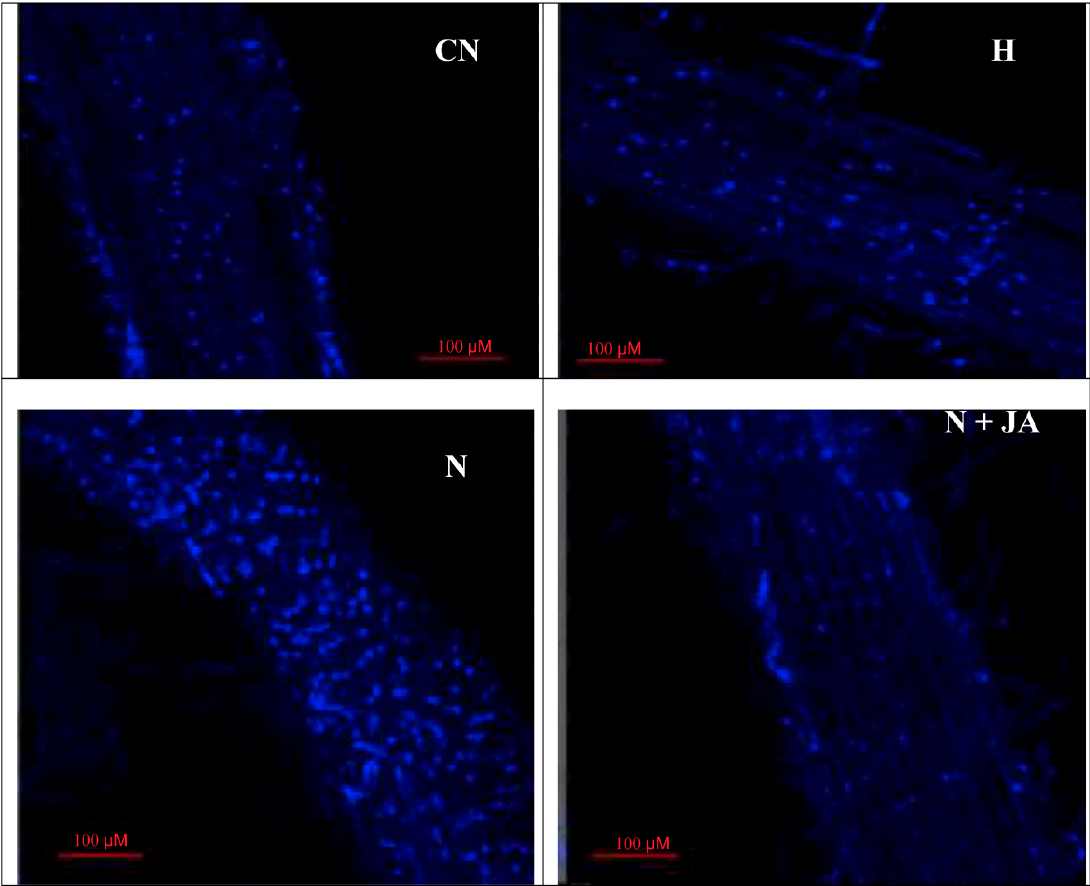
Figure 3. Effect of seed soaking treatment of JA (100 nM) on nuclear damage in tomato seedlings after seven days of nematode inoculation. N = nematode, H = 100 nM JA, scale bar = 100 μ m.